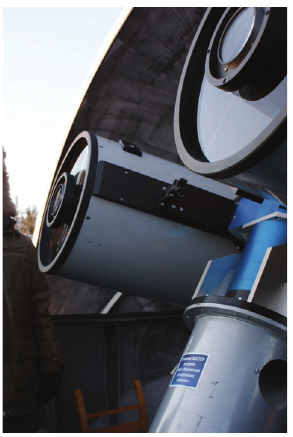
Figure 8: MASTER II (Kourovka, near Ekaterinburg, Ural State